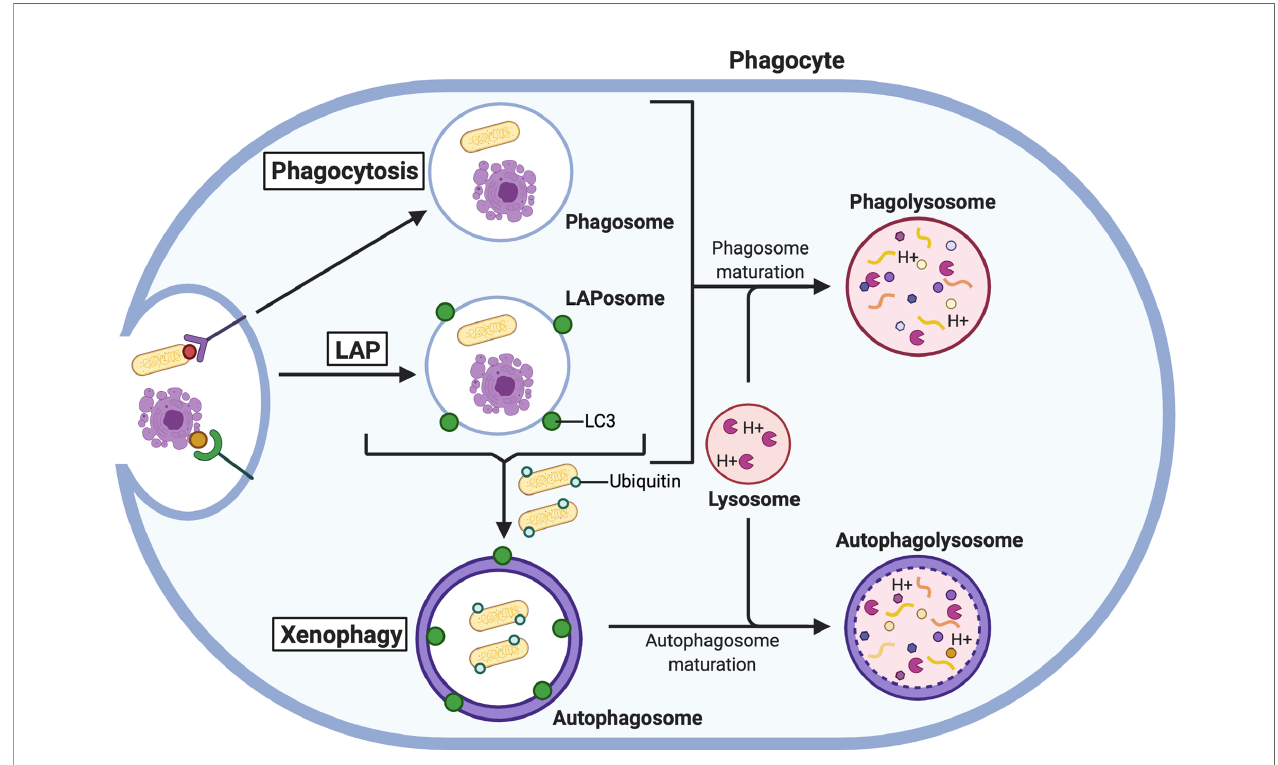
FIGURE 4 | The autophagic response aids the phagocytic pathway. Phagocytosed microbes and apoptotic cells are degraded in PLs formed from the fusion of lysosomes with phagosomes. Under certain conditions, LC3 is recruited to phagosomes for LAP to create more robust PLs. Microbes that escape PL-mediated degradation are ubiquitinated in the cytosol and degraded in autophagolysosomes via